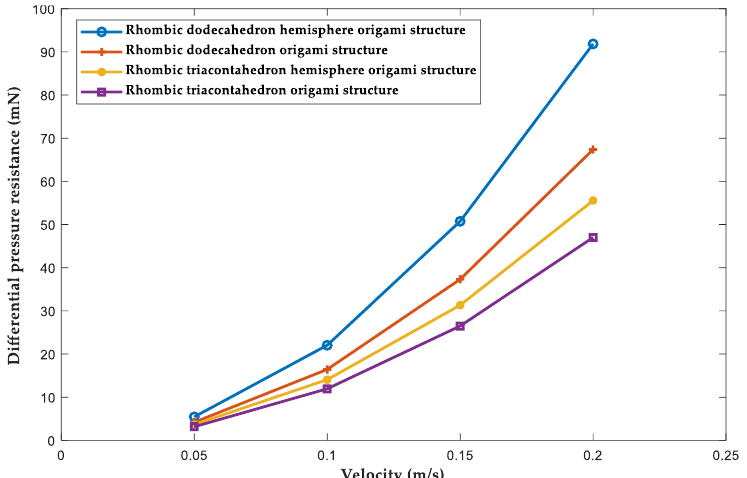
Figure 3. The relationship curve between differential pressure resistance and swimming speed of different origami structures.